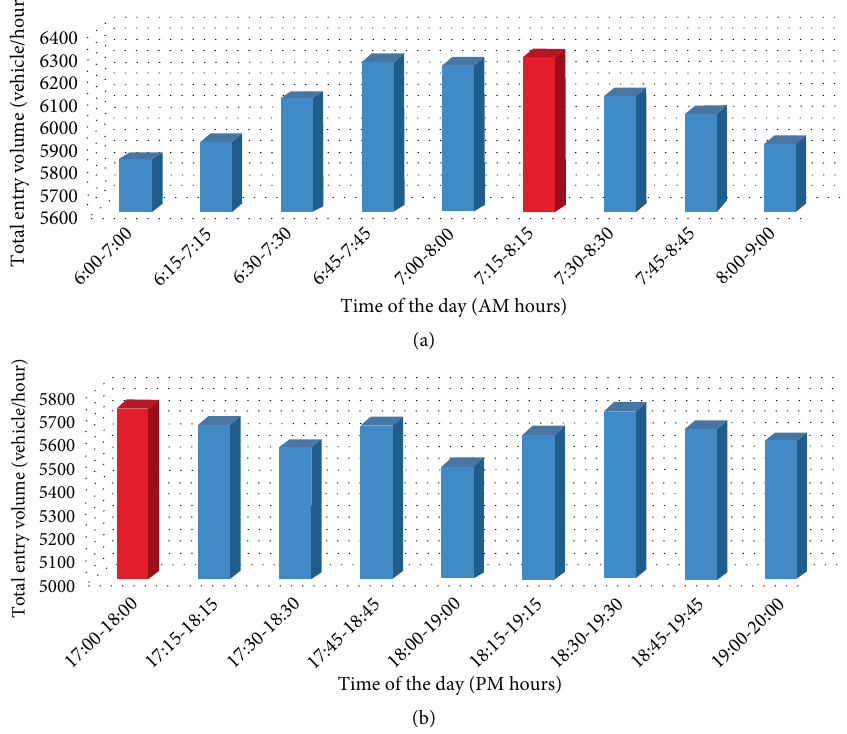
Figure 2: Hourly volumes for the conventional roundabout. (a) AM hourly volumes for the conventional roundabout. (b) PM hourly volumes for the conventional roundabout.